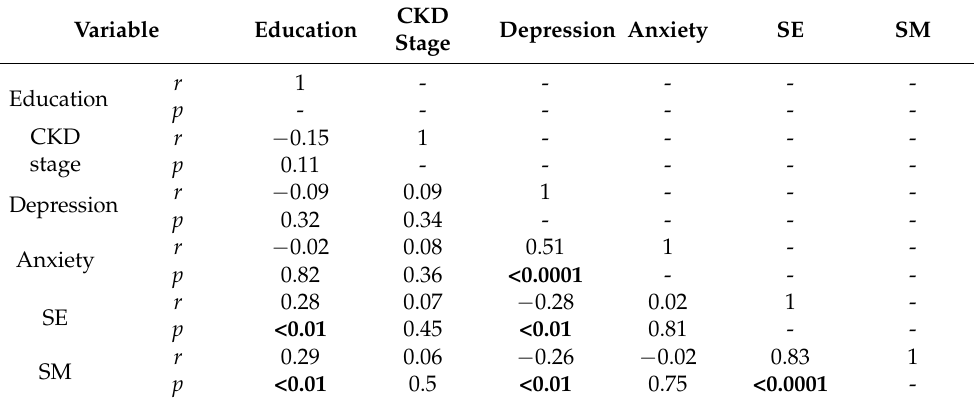
Table 5. Spearman’s rank correlation analysis between the selected study